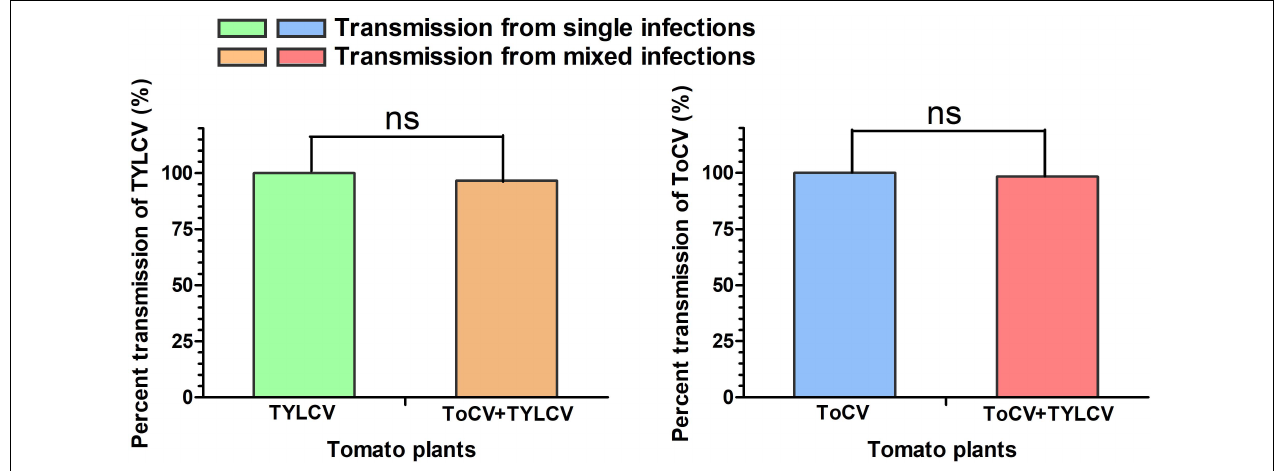
FIGURE 6 | Percent transmission of Tomato chlorosis virus (ToCV) and Tomato yellow leaf curl virus (TYLCV) by Bemisia tabaci . ns indicate no significant difference between single infection and mixed infection (chi square test, P < 0.05).